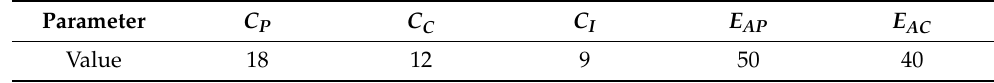
Table 4. Related Parameters of the Attacker.